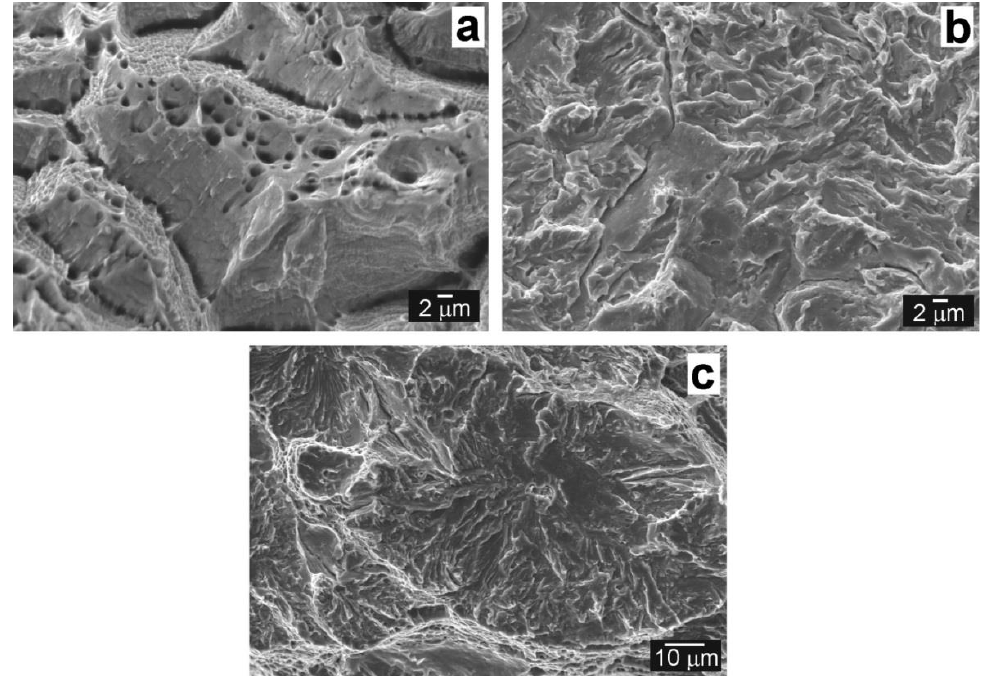
Figure 12. Fracture surfaces of the samples failed after room-temperature tensile test of T92 / TP316H dissimilar weldments: state QT PWHT with failure in T316H BM region ( a ); state QT PWHT + H with failure in interfacial region T92 BM / Ni WM ( b ); the view of the “fish-eye” fracture morphology ( c ).